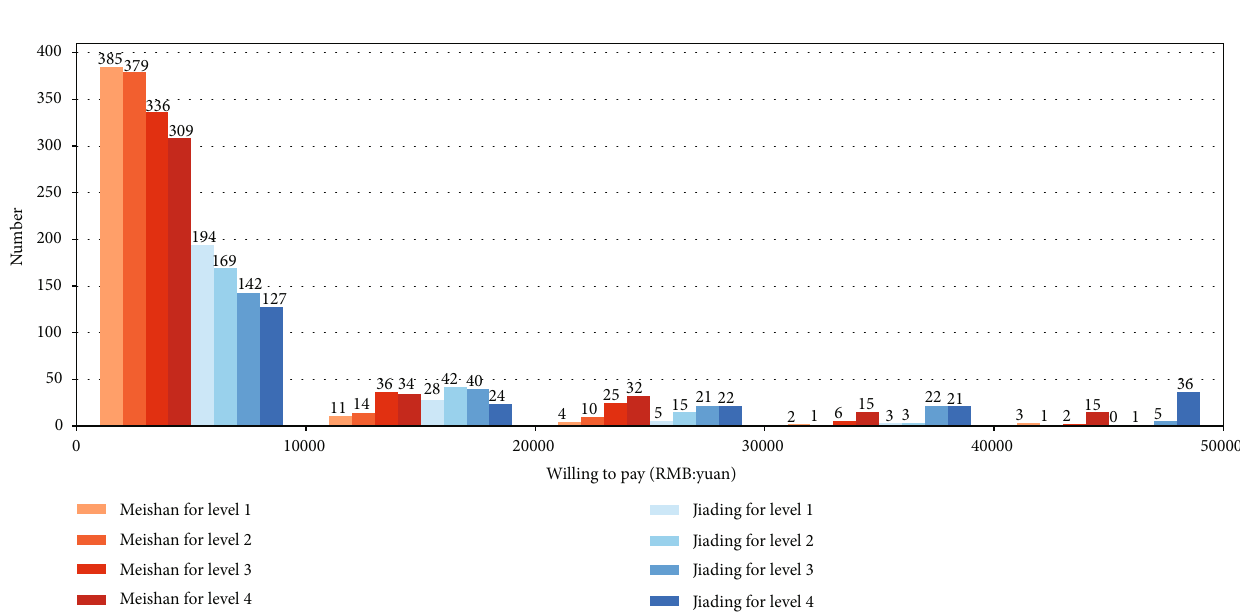
Figure 4: Willingness to pay for di ff erent levels of ADAS or autonomous driving